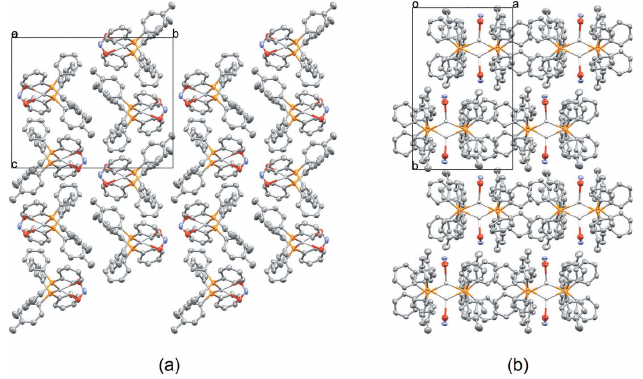
Figure 2 Packing diagrams as viewed along the ( a ) a and ( b ) c axes. Hydrogen atoms are omitted for clarity.